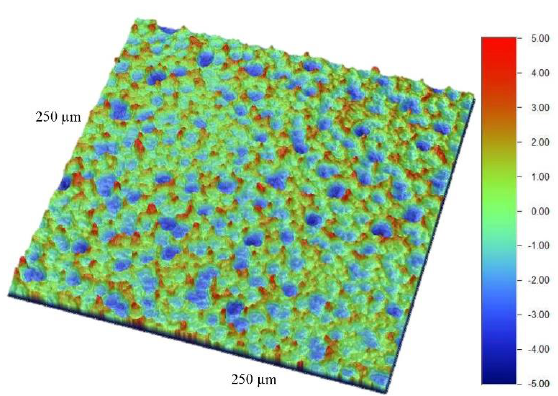
Figure 2. Surface roughness of the implant surface. Note the regular and homogeneous roughness structure with rounded valleys and peaks between the valleys.